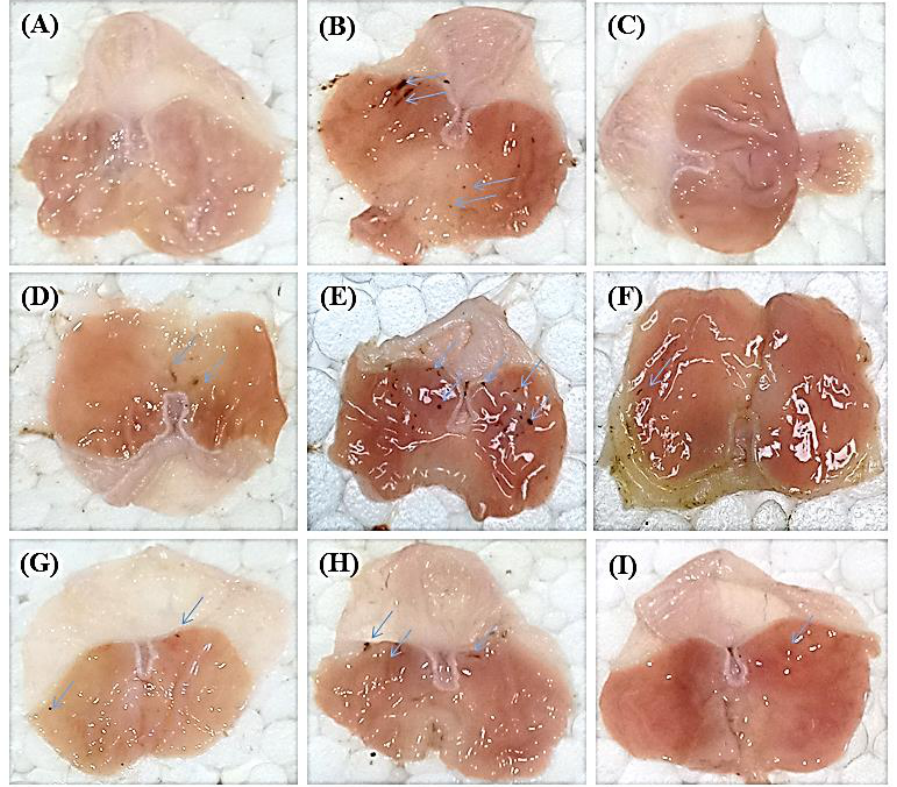
Figure 2. Macroscopic view of stomach mucosa in the acute gastric ulcer model in the H. crispum total methanol extract (CME) treated gastric tissues as well as its various fractions; normal group showing no ulcer ( A ), disease control group showing 5 small ulcers and 2 hemorrhagic streaks ( B ), omeprazole treated group showing one small ulcer( C ), CME treated group showed only 1 small ulcer ( D ), n -hexane treated group showing many small ulcers ( E ), chloroform treated group showing one ulcer and one hemorrhagic streak, ( F ), ethyl acetate treated group showing 2 small ulcers and ( G ), n -butanol treated stomach showing 2 small ulcers and 2 large streaks ( H ) and remaining aqueous fraction ( I ) treated groups showing red coloration and small ulcers. Blue arrows show ulcers and hemorrhagic streaks produced due to ethanol-induced damage to stomach